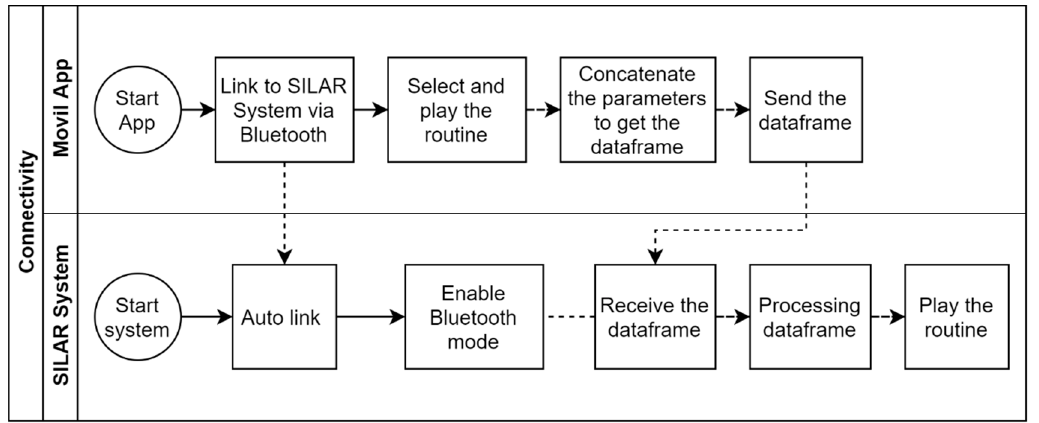
Figure 7. Connectivity between the mobile app and mechanical system based on SILAR method.